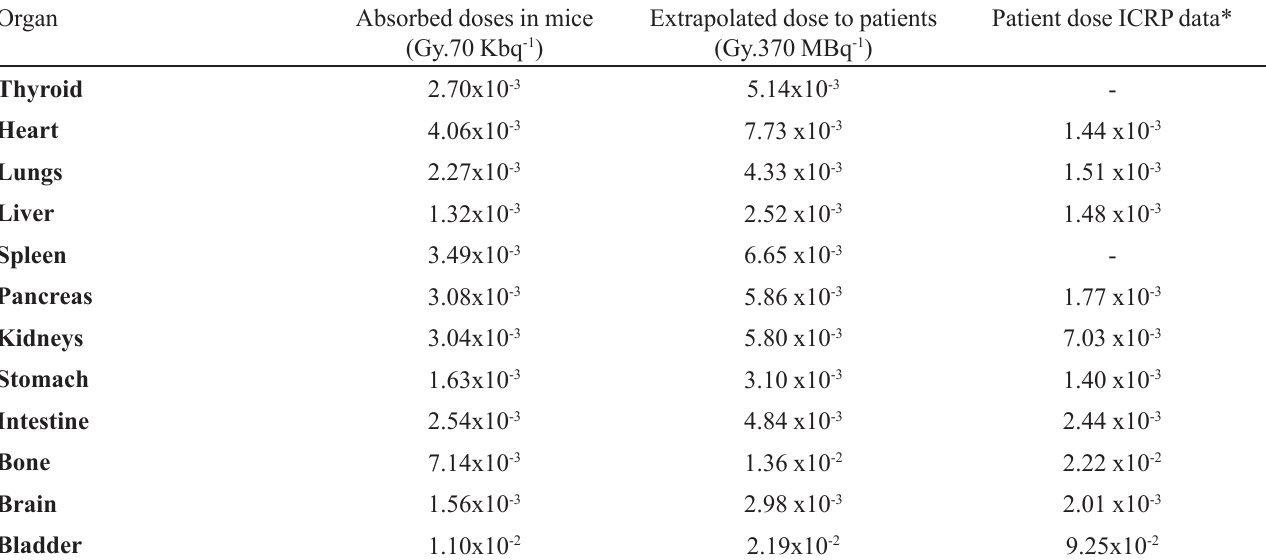
TABLE II - Organ absorbed dose in mice and extrapolated to patients. The results were compared with literature data (ICRP 53). *Values were converted to clinically used doses (370 MBq)